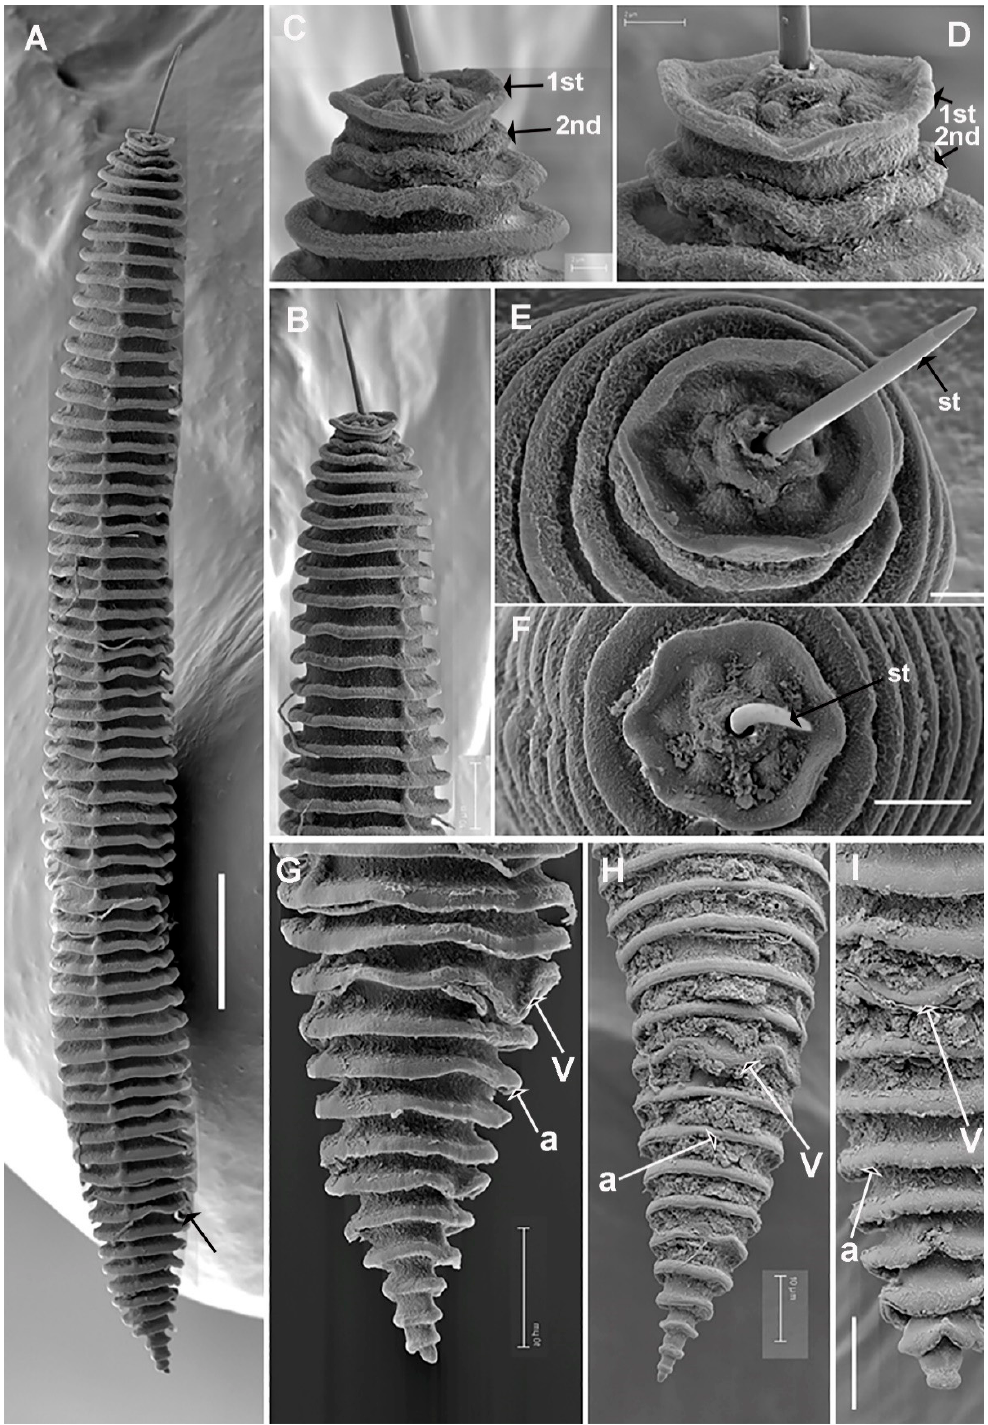
Figure 10. SEM micrographs of Criconema plesioannuliferum sp. nov. females. ( A ), whole female; ( B ), anterior region; ( C , D ), detail of 1st and 2nd body annuli; ( E , F ), in face view; ( G – I ), posterior region showing vulva and anus (arrowed). Abbreviations: a = anus; st = stylet; V = vulva; 1st, 2nd = first- and second-body annuli. Scale bars: ( A ) = 25 µm; ( B ) = 10 µm; ( C – E ) = 2 µm; ( F ) = 5 µm; ( G – I ) = 10 µm.